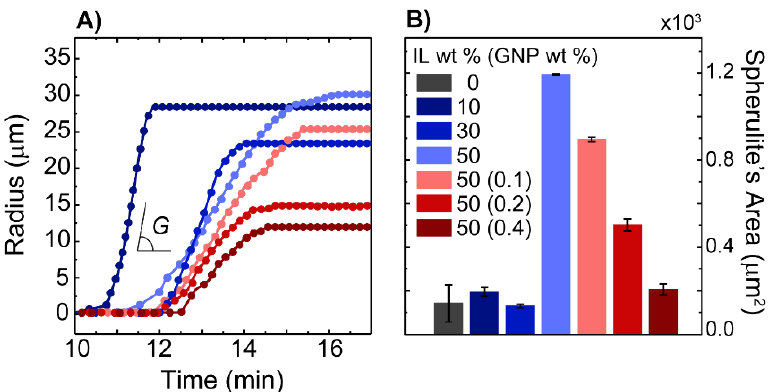
Figure 4. ( A ) Plot of the radii of spherulites vs. time used to estimate the spherulite growth rate (G = tan −1 ∡ ). ( B ) Average values for the area of spherulites; each bar is the average of three measurements presented with one standard deviation.